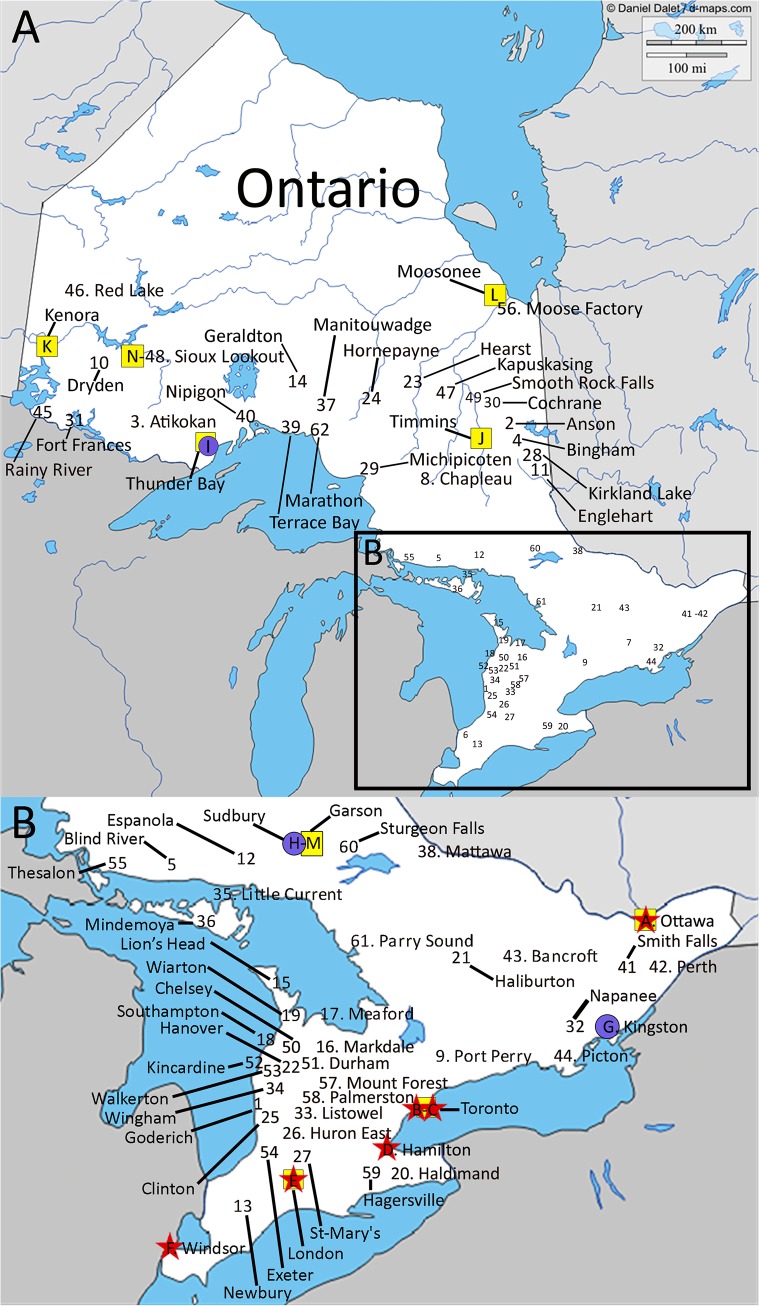
Location of RST EDs, Level 1 and 2 trauma centers, and airbases in ON.The Ontario map was originally taken from http://d-maps.com/. All the maps are protected by copyright. They are free for any use, even commercial, in the following conditions:-The exact URL where the original map comes from must be mentioned-The number of used maps is limited to 10 for a publication (Web, DVD, book…)-The number of used maps is unlimited with BeGraphic GIS use.The cities where the 62 RST EDs are located are identified on the map. The red stars (A, B, C, D, E, F) represent the Level 1 trauma centers (refer to [18] for definition of trauma centers). The blue circles (G, H, I) represent the Level 2 trauma centers (refer to [18] for definition of trauma centers). The yellow square (I, J, K, L, M, N) represent the location of the airbases. Trauma centers: A = The Ottawa Hospital—Civic Campus; B = St. Michael's Hospital; C = Sunnybrook Health Sciences Centre—Bayview Campus; D = Hamilton Health Sciences—Hamilton General Hospital; E = London Health Sciences Centre—Victoria Hospital; F = Hotel-Dieu Grace Hospital; G = Kingston General Hospital; H = Sudbury Regional Hospital—St. Joseph's Health Centre; I = Thunder Bay Regional Health Sciences Centre.